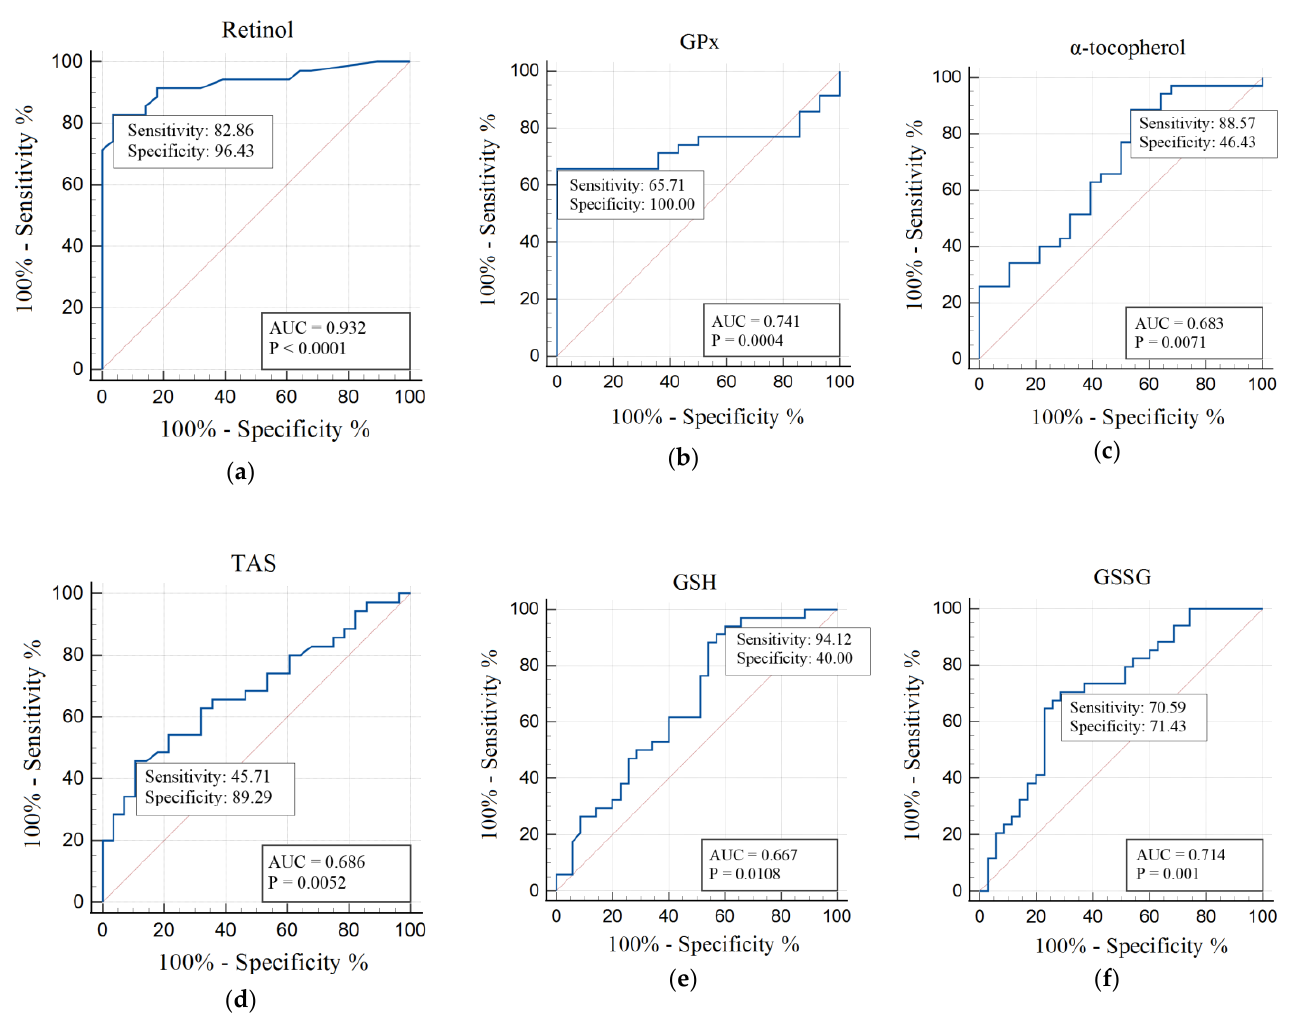
Figure 2. ROC analysis of total antioxidant status, enzymatic and non-enzymatic antioxidant levels in Group 1 men compared with those in the control group ( a – d ) and in Group 2 men in comparison with Group 1 ( e , f ). Abbreviations: AUC, area under curve; GPx, glutathione peroxidase; GSH, reduced glutathione; GSSG, oxidative glutathione; p , statistically significant differences; TAS, total antioxidant status.